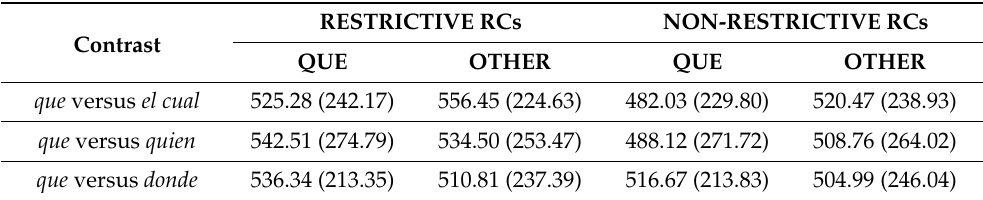
Table 9. Mean total reading times (ms) by condition over R4, R5, and R6 for the three contrasts. The numbers in parentheses indicate the standard